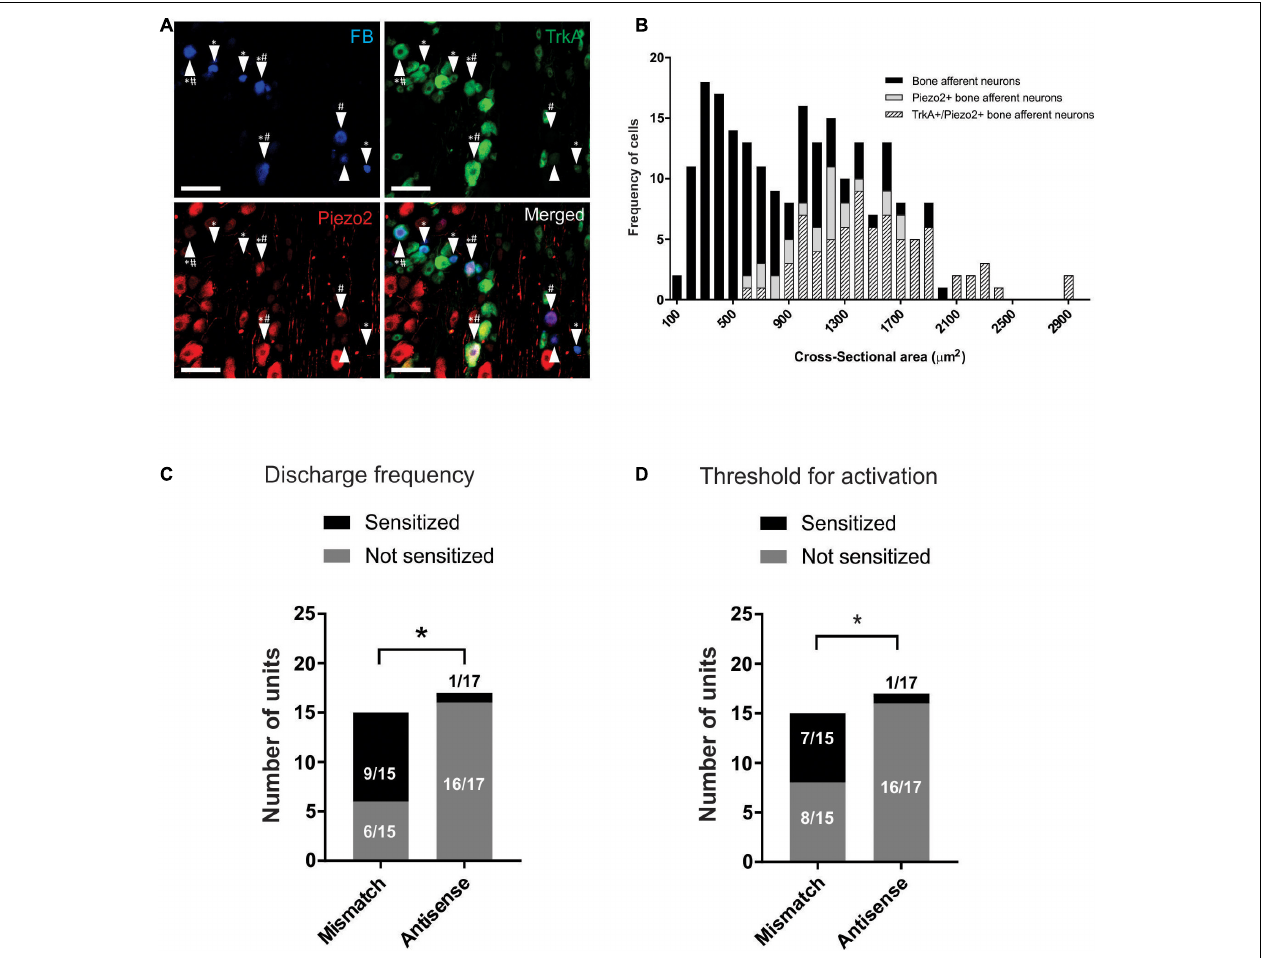
FIGURE 4 | Piezo2 knockdown prevents NGF-induced sensitization of A δ bone afferent neurons. (A) Retrograde labeling of bone afferent neurons (FB, blue, arrowheads) revealed that a substantial proportion of neurons that innervate bone express Piezo2 (red, hashes) and the NGF receptor TrkA (green, asterisks). Scale bars = 100 µ m. (B) Frequency histogram showing that the majority of medium-sized bone afferent neurons expressed Piezo2, and that most Piezo2 expressing bone afferent neurons also expressed TrkA. (C) A significantly lower proportion of A δ bone afferent neurons were sensitized (increased discharge frequencies) by NGF in Piezo2 antisense treated animals compared to mismatch control animals [chi-square test, X 2 (1, N = 32) = 10.86,* P < 0.05, n = 15 mismatch/17 antisense, N = 8 mismatch/9 antisense]. (D) A significantly lower proportion of A δ bone afferent neurons were sensitized (lower thresholds for activation) by NGF in Piezo2 antisense treated animals compared to mismatch control animals (chi-square test, X 2 (1, N = 32) = 7.069,* P < 0.05, n = 15 mismatch/17 antisense, N = 8 mismatch/9